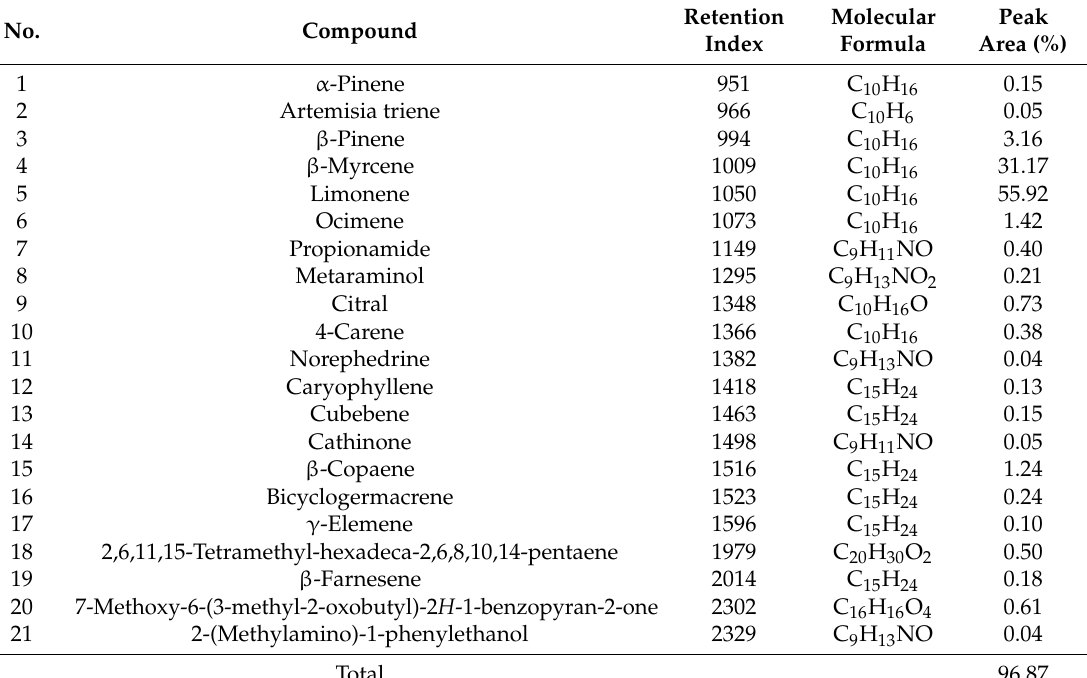
Figure 1. Total ion chromatogram of aroma components from pomelo peel essential oil (PPEO). Table 1. Chemical components of essential oils.